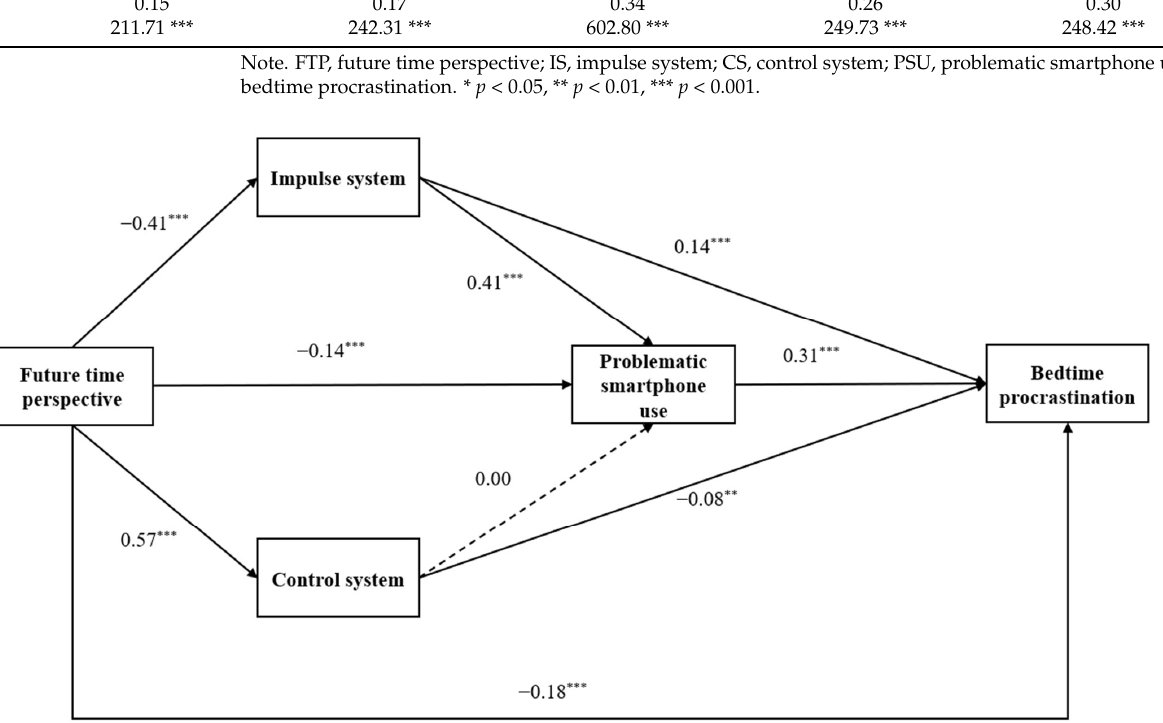
Figure 1. The serial mediation effect of dual-mode self-control and problematic smartphone use in the relationship between future time perspective and bedtime procrastination (standardized coeffi-